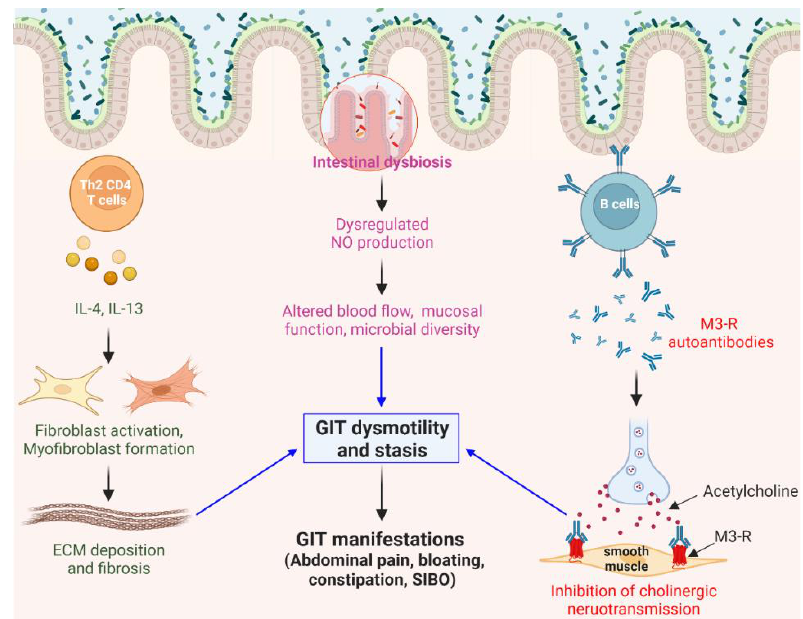
Figure 2. Proposed mechanism of SSc-associated gastrointestinal involvement. GIT involvement of SSc is likely associated with neuropathy and myopathy caused by the activation of the immune system. Th2 CD4 T cells induce myofibroblast formation and subsequent perivascular and interstitial fibrosis, affecting GIT dysmotility. Anti-muscarinic receptor (M 3 -R) autoantibodies can reduce GIT contractility by interfering with the acetylcholine binding on intestinal smooth muscle. Additionally, dysbiosis of commensal gut microbiota, which may regulate NO production, may influence blood flow, mucosal integrity, and GIT motility. Diminished peristalsis and luminal content stasis may be involved in the development of GI manifestations in SSc.